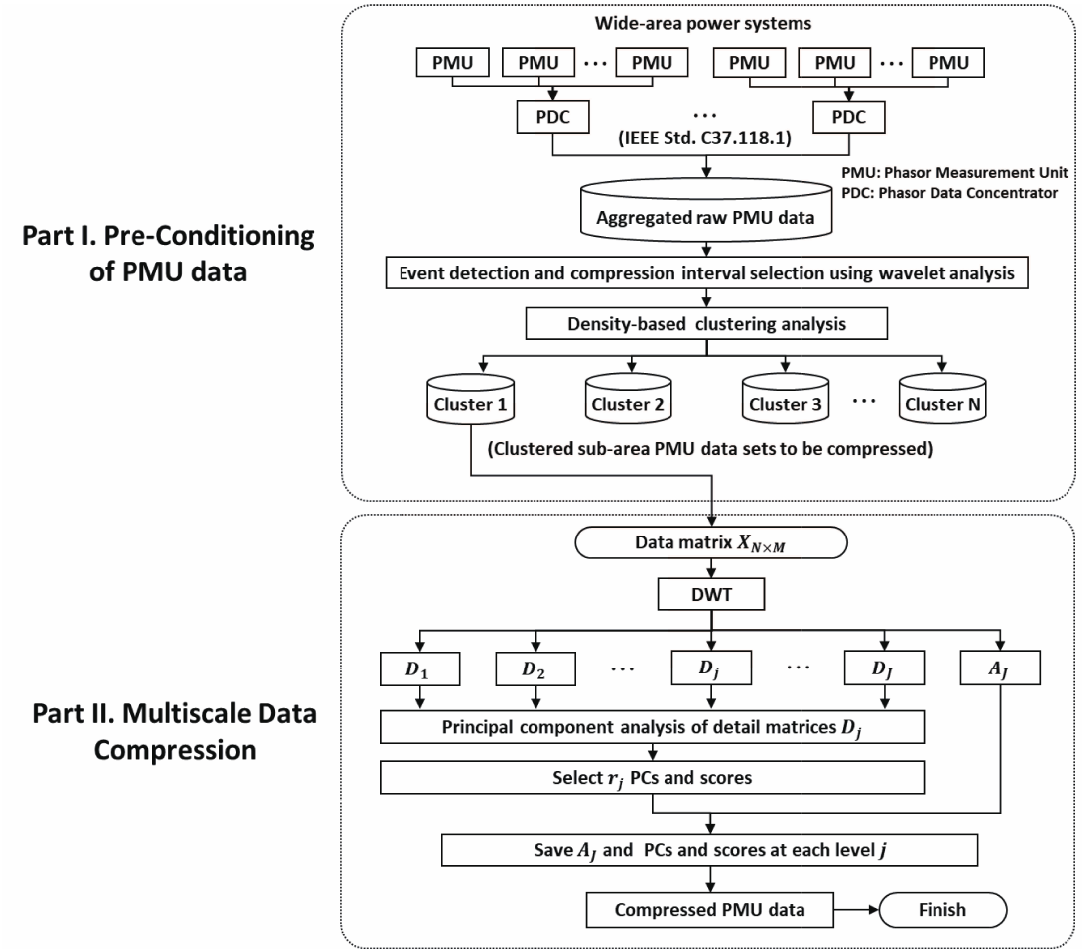
Figure 2. Flowchart of PMU data